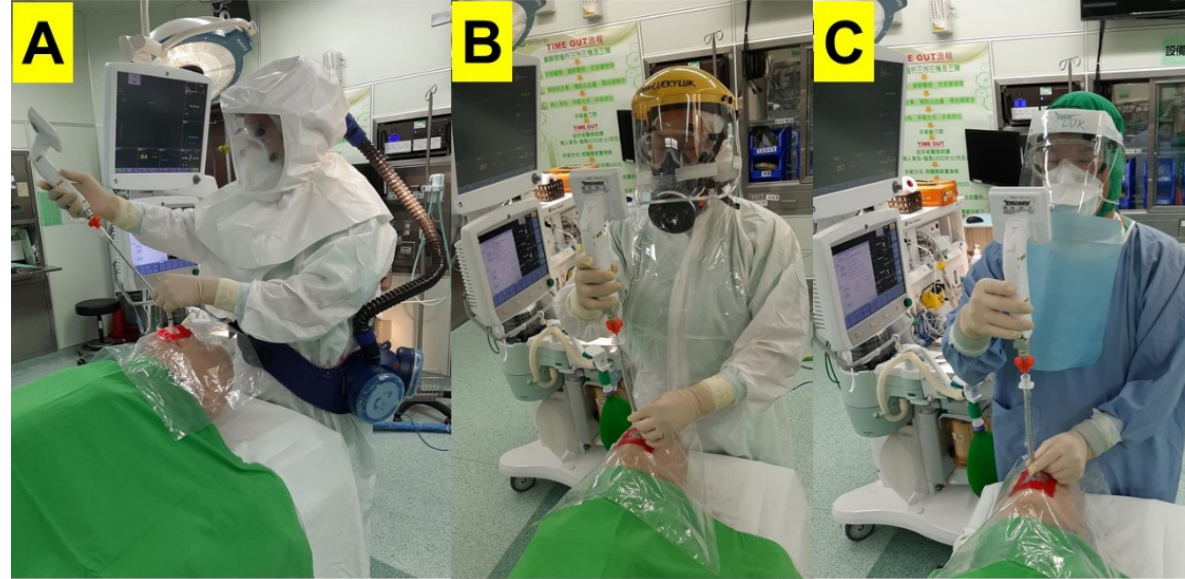
Figure 7. Mannequin demonstration of endotracheal intubation using the video intubating stylet through a piece of plastic sheet. ( A ) Stylet with loaded endotracheal tube introduced into patient’s mouth. ( B ) Stylet directed towards vocal cords under visual guidance from the monitor on the proximal end. ( C ) Endotracheal tube advanced off the stylet once past the vocal cords. PPE with powered air-purifying respirator, P-100, and N-95 respirators were shown in this figure. (Courtesy photos reproduced from Asian Journal of Anesthesiology, Taiwan Society of Anaesthesiologists with permission).